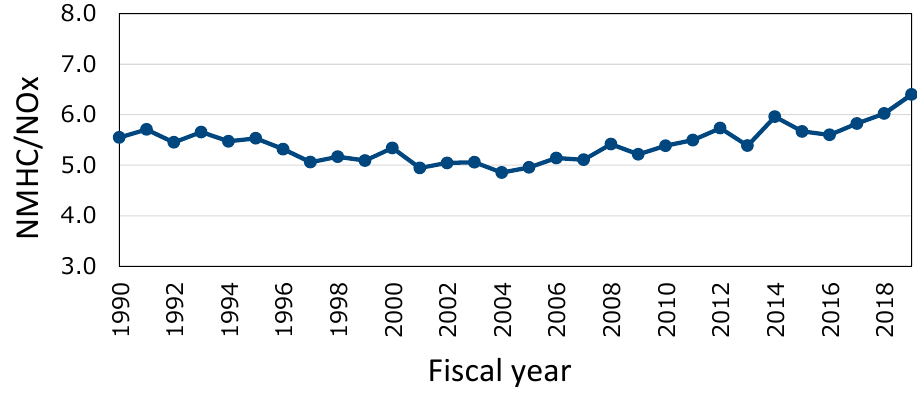
Figure 24. Trend in the annual averages of NMHC/NOx. NMHC: same as Figure 23. NOx: annual averages of three-hour average of NOx from 6 a.m. to 9 a.m. at seven stations; same as Figure 23. The relationship between Ox on the one hand and NOx and NMHCs on the other from 1990 to 2019 is shown in Figure 25. In terms of decade units, both NMHC concentration and NOx concentration have been declining. On the other hand, Ox concentration has been gently rising.